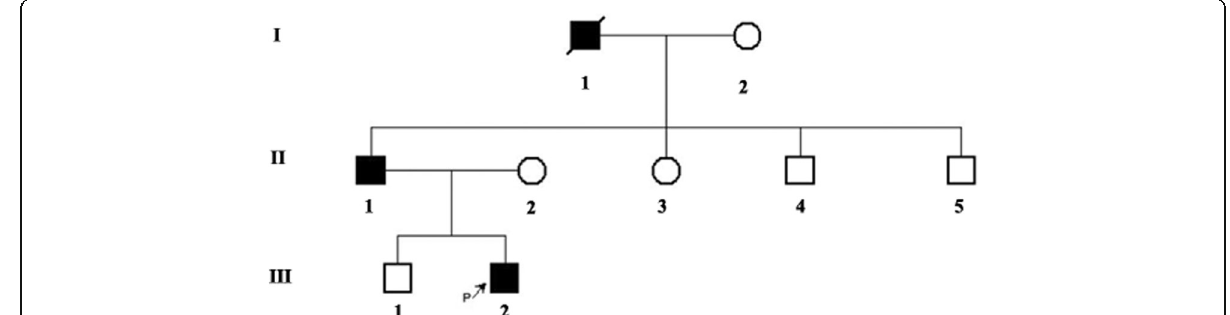
Fig. 3 Pedigre of family 2.